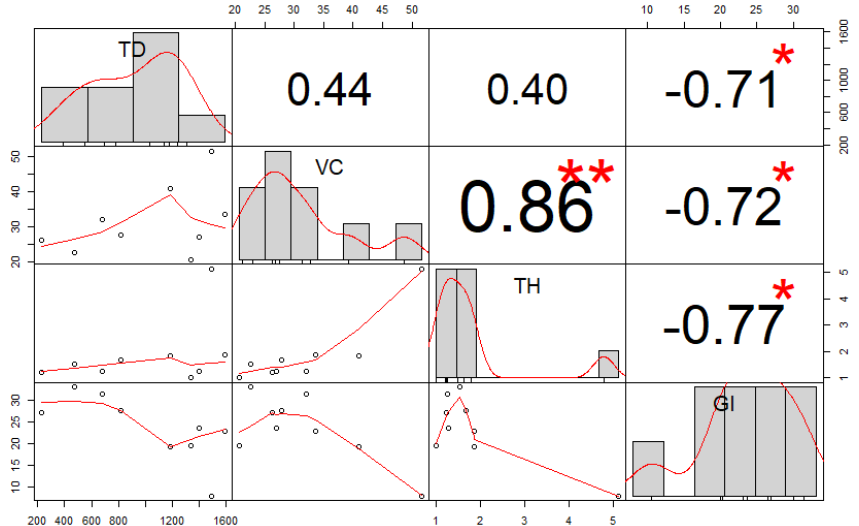
Figure 10. FR structural parameters Correlation Matrix between different FR stretches. In this symmetric matrix, the cells of the main diagonal shows a FR structural parameter (TD is Tree Density, VC is Vegetation Cover, TH is Tree Height, and GI is Grass Infestation) and its corresponding values in the different FR stretches. The other cells show the correlation value between different FR structural parameters, where the more asterisk (“*”) symbol occurs, the more correlated two variables